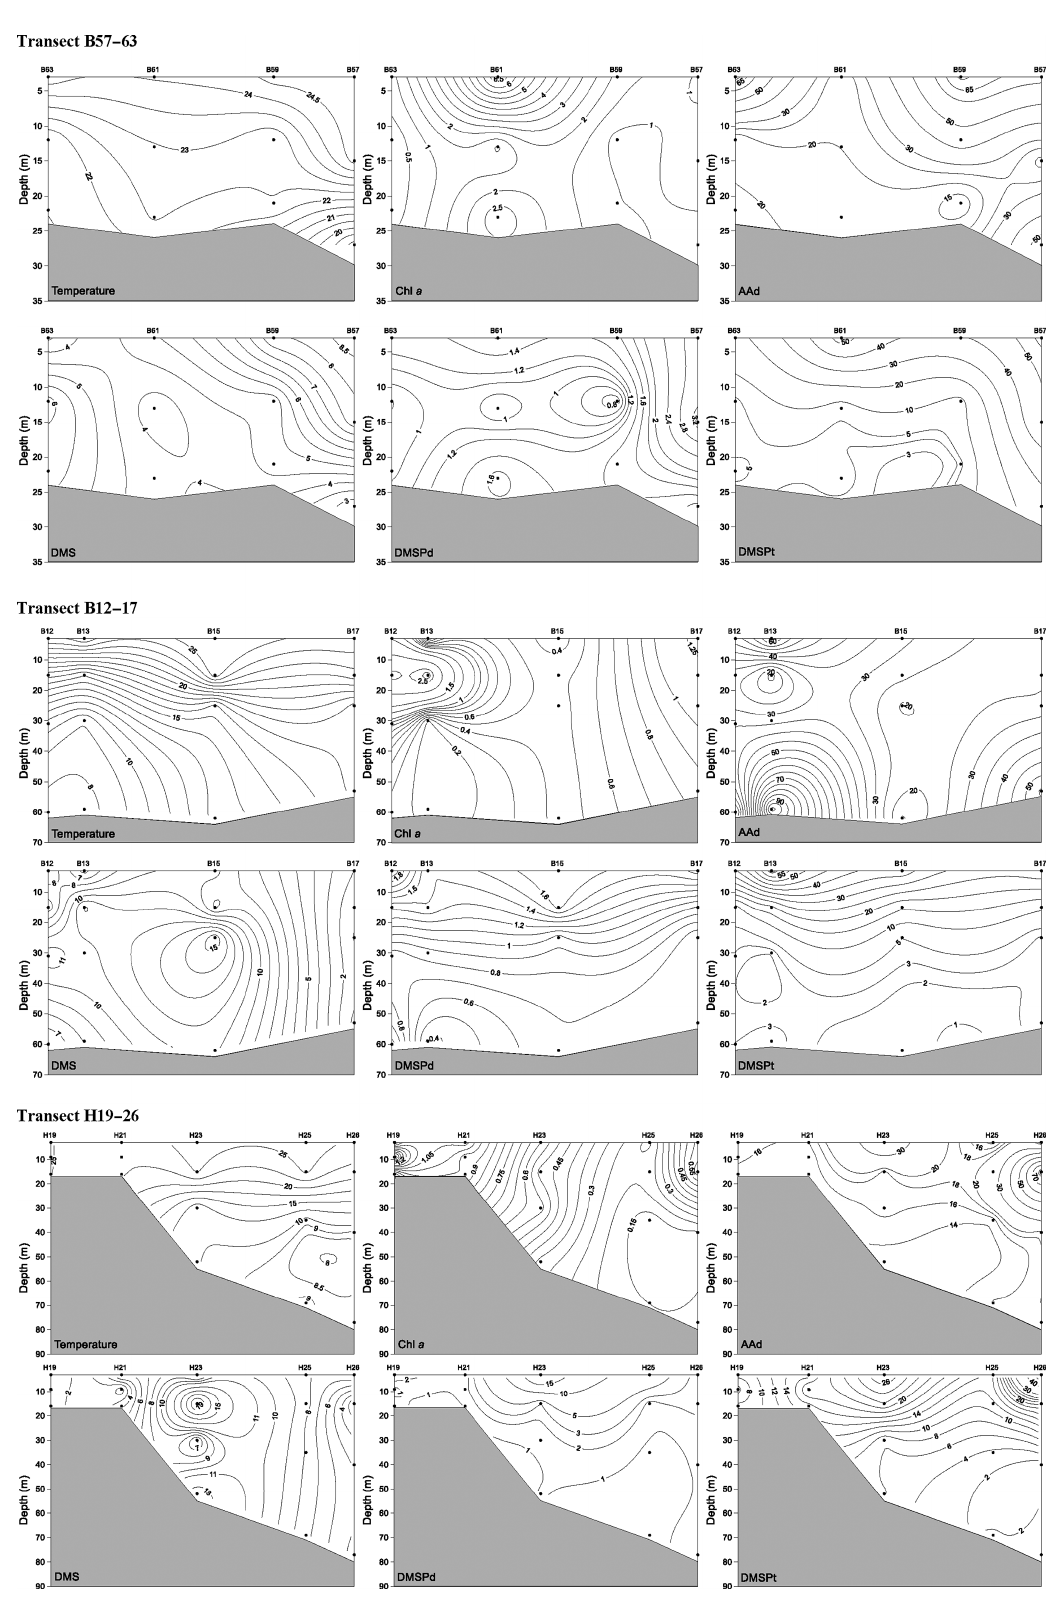
Figure 4. Vertical profiles of temperature ( ◦ C), Chl a (µgL − 1 ), AAd (nmolL − 1 ), DMS (nmolL − 1 ), DMSPd (nmolL − 1 ), and DMSPt (nmolL − 1 ) along transect B57–63, transect B12–17, and transect H19–26 during summer. A kriging method is used for interpolating con- tours. The black dots represent sampling